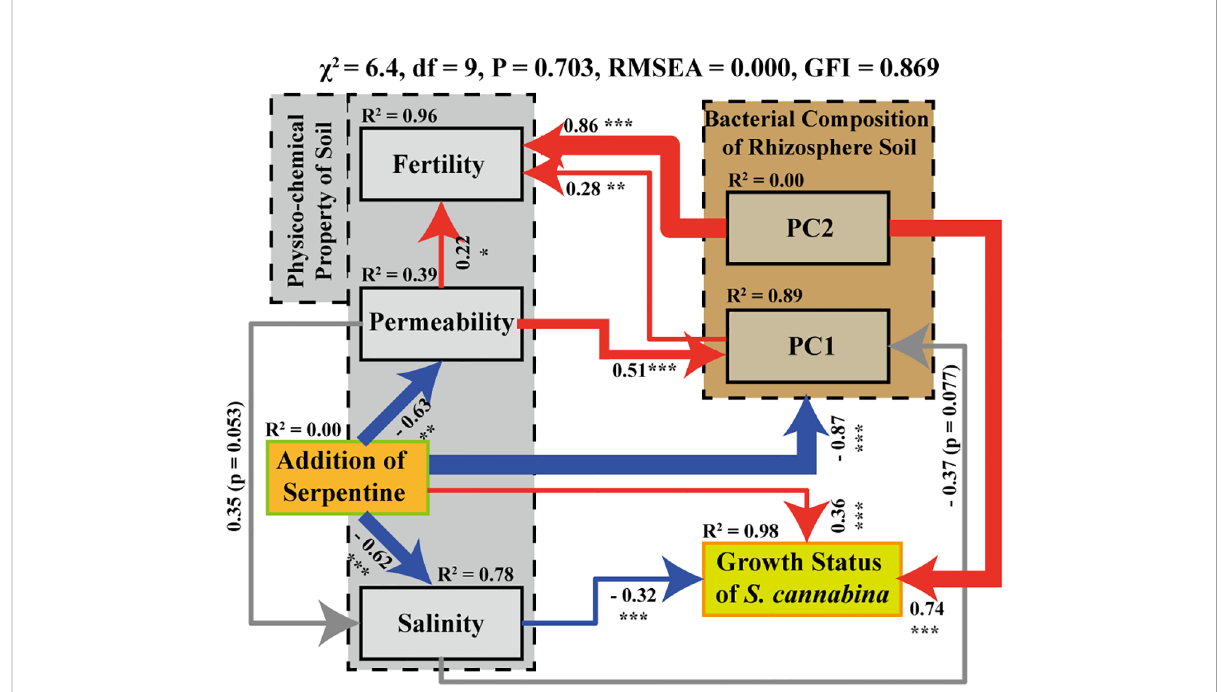
FIGURE 6 SEM model between the treatment of organic fertilizer combined with river-sand and serpentine and biotic or abiotic environmental variables. Among them, content of Avail. Mg re fl ects the treatment of SS (mainly as the addition of serpentine); Avail. Na, TN, and moisture content were used to re fl ect the physico-chemical indices of salinity, fertility, and permeability in soil respectively; dry-biomass re fl ect the growth status of S. cannabina ; the fi tted values of PC1 (distinguishing FS and SS) and PC2 (distinguishing OF and FS) in PCA analysis (Figure 2C) indicated the difference of bacterial community composition in different samples (the number marked on the connecting line between factors indicates the correlation between the two factors, and the larger the R 2 , the stronger the correlation; the line thickness of the connecting line also re fl ects the magnitude of R 2 ; “ *** ” on the line represents signi fi cance at P < 0.001, “ ** ” represents signi fi cance at P < 0.01, and “ * ” represents signi fi cance at P < 0.05; the red and blue colors on a line represent positive correlation and negative correlation